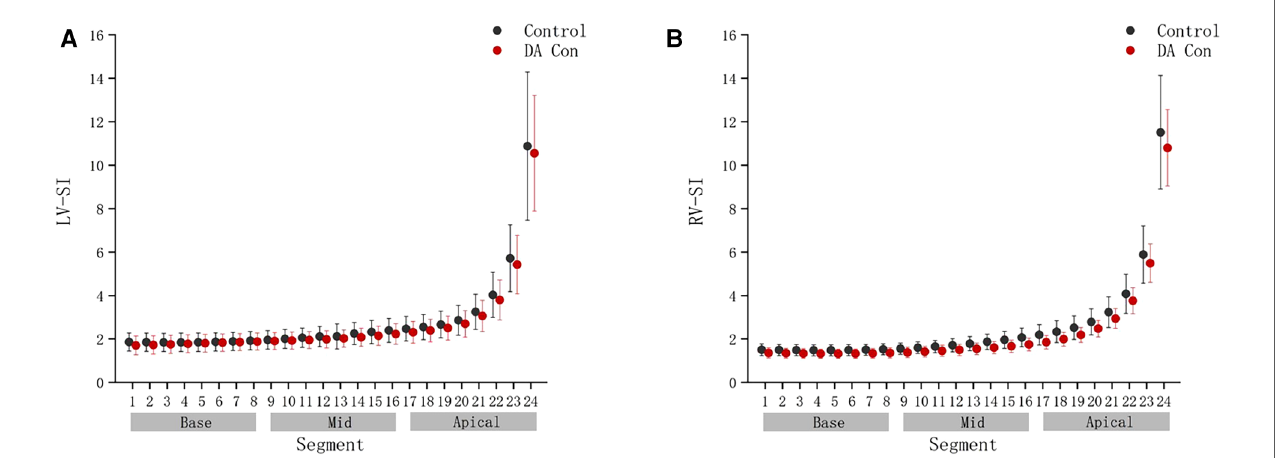
FIGURE 3 Comparison of ventricular 24-segment sphericity index (SI) from the base to the apex between the control group and ductus arteriosus premature contraction (DA Con) group. ( A ) Left ventricle (LV) 24-segment SI values in the DA Con group and control group ( P <0.05). ( B ) Right ventricle (RV) 24-segment SI values in the DA Con group and control group ( P <0.05).